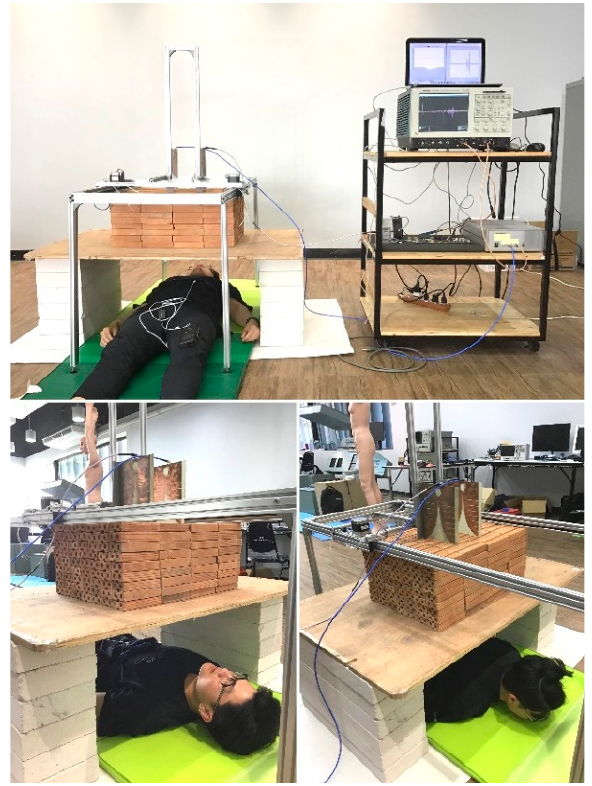
Figure 11. Experimental setup for detection of human subject underneath layers of stacked clay bricks in supine and prone positions using the FPGA scheme.